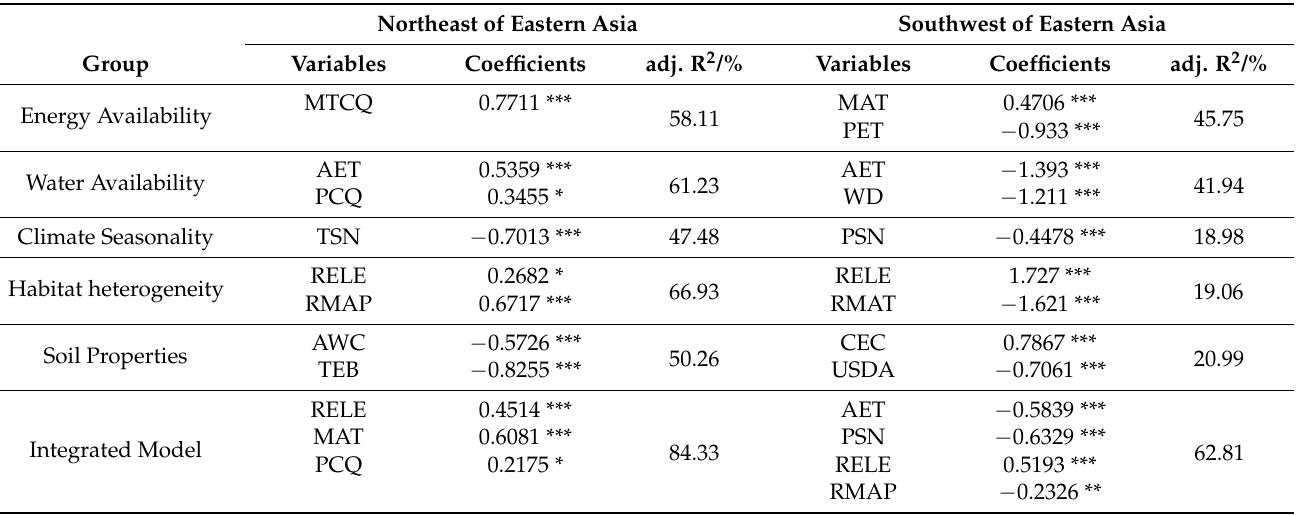
Table 4. Stepwise regression models for each group of variables and integrated model for two regions in eastern